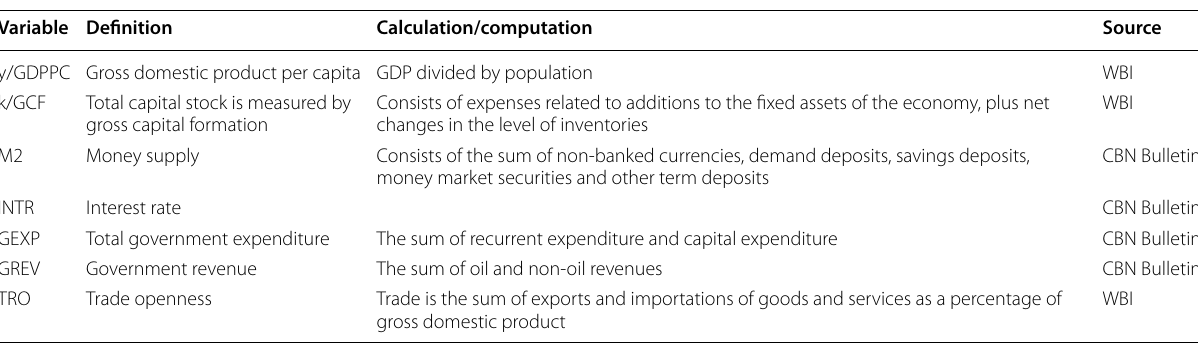
Table 1 Source and computation of data Variable Definition